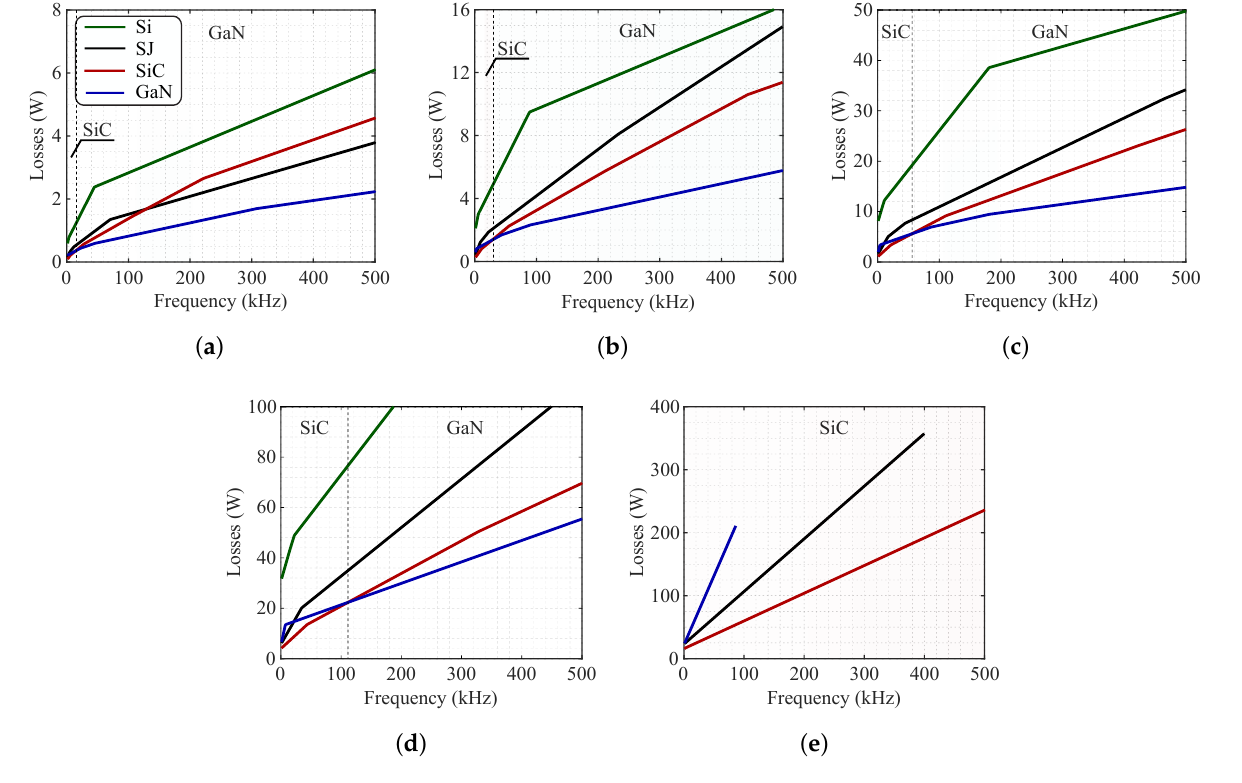
Figure 10. Total losses: ( a ) 1 kW, ( b ) 2 kW, ( c ) 4 kW, ( d ) 8 kW and ( e ) 16 kW. Table 8. Best performance ranges for the evaluated powers and